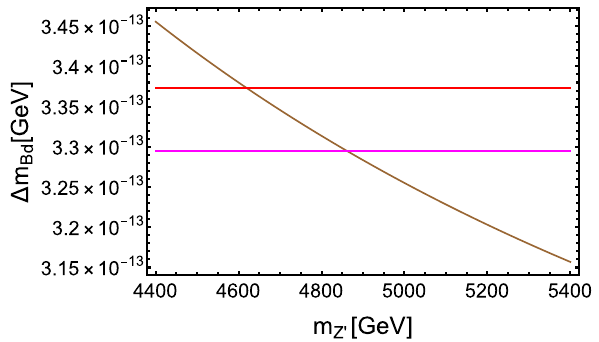
− ¯ B 0 mass splitting as a function of the Z (cid:10) d d